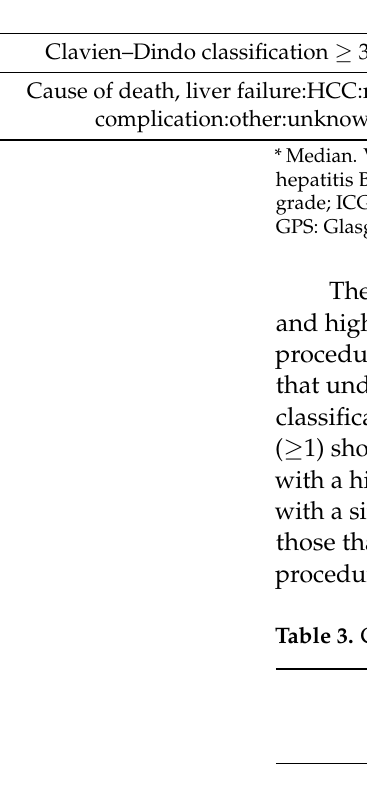
Open Hepatectomy ( n = 304)